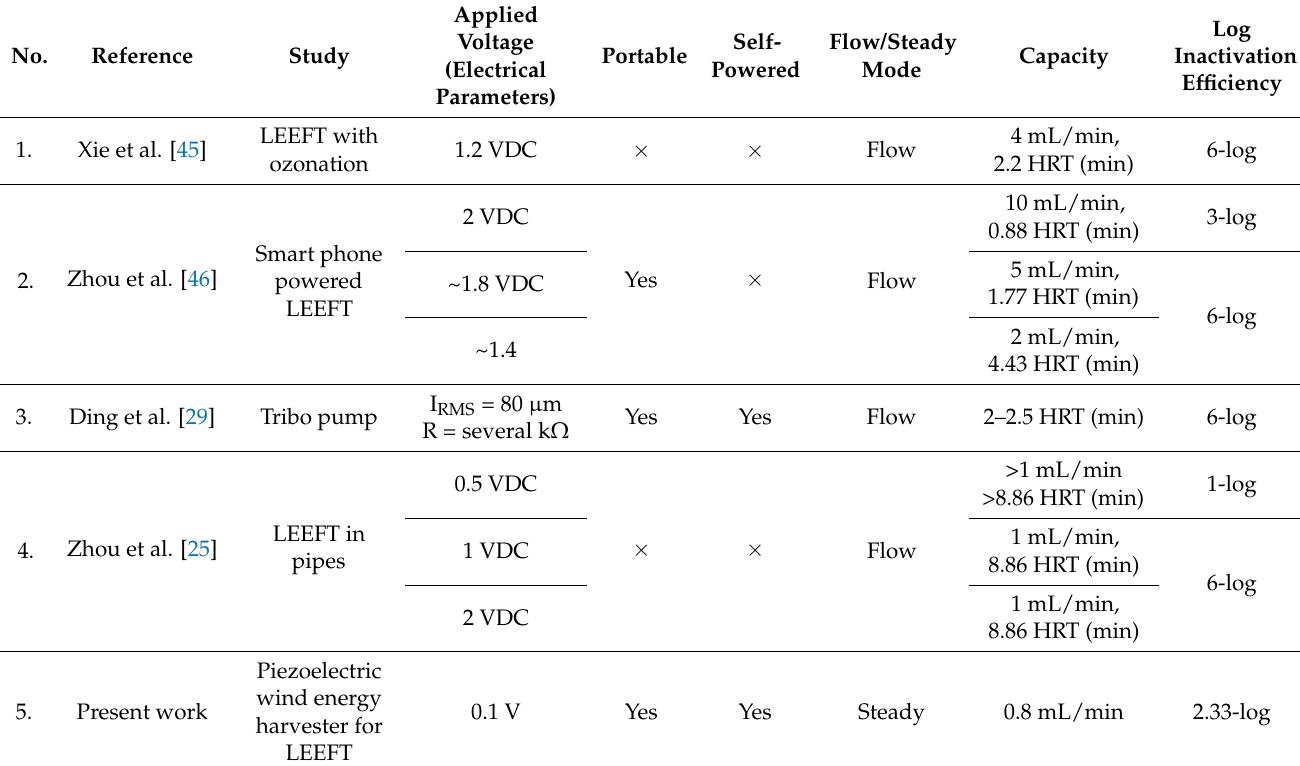
Figure 11. SEM images: ( a ) copper oxide nanowires before the experiment; ( b ) copper oxide nanowires after the experiment (broken); ( c ) live E. coli bacteria (before treatment) and ( d ) E. coli bacteria (after treatment). Table 3. Comparison of previously reported LEEFT water